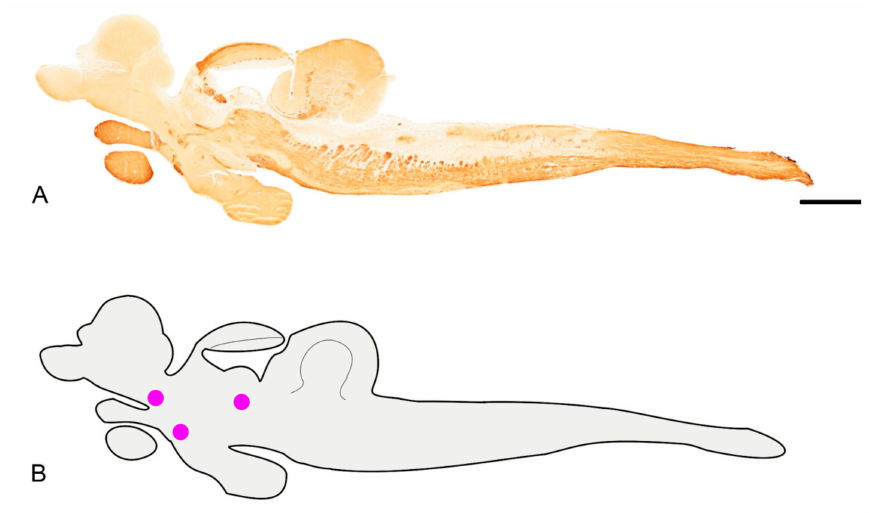
Figure 1. Overview of the brain of adult N. furzeri . ( A ) Sagittal section of the whole brain showing di ff use neuronal projections and very few groups of cholinergic nuclei. ( B ). Schematic view of sagittal section A showing in violet the identified groups of cholinergic nuclei (Ch-1, Ch-2 and Ch-3). Scale bar = 2.5 µ m.